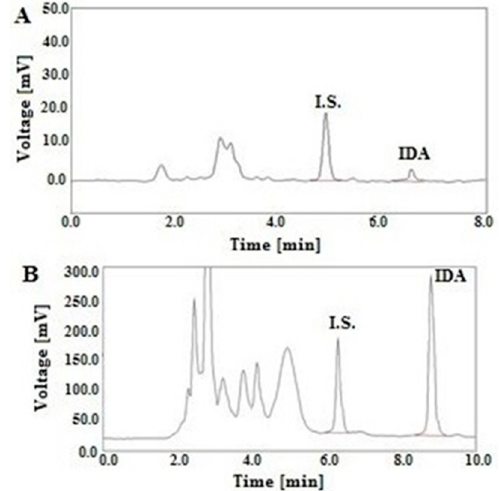
Figure 1. Representative LC chromatograms of a patient’s human plasma extract collected at 4 h ( A ), and a urinary sample collected between 12 and 20 h ( B ) after oral administration of IDA at a dose of 10 mg on the 1st day of the O-TIDA / O-TE therapy, according to the CWS-2006 protocol, at the following IDA levels: A—1.44 ng / mL of IDA and DAU (I.S.) at a concentration of 20 ng / mL; B—142.33 ng / mL of IDA and DAU (I.S.) at a concentration of 100 ng / mL.